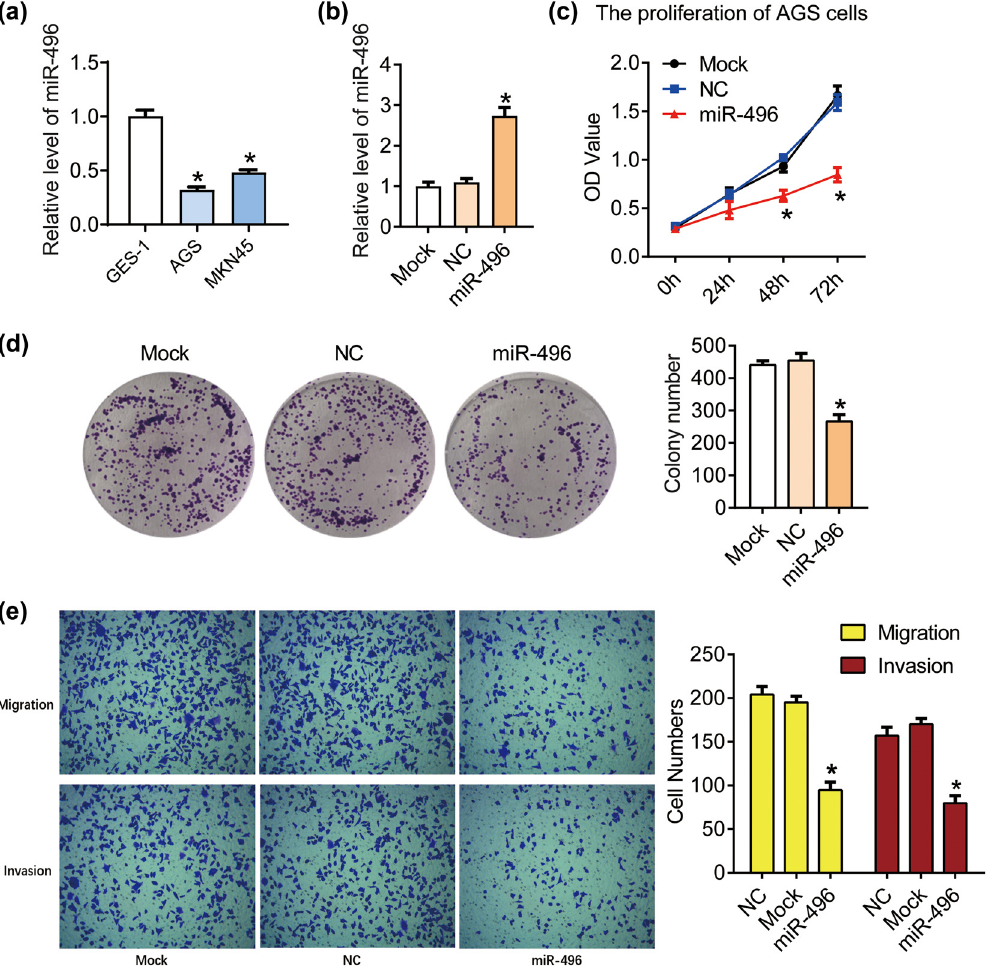
Figure 1: miR - 496 inhibited the proliferation and metastasis in gastric cancer cells. ( a ) QPCR was performed to detect the level of miR - 496 in AGS cells. ( b ) The level of miR - 496 in AGS cells transfected with miR - 496 mimics was detected by qPCR. Relative level of miR - 496 was analyzed using 2 − ΔΔ Ct method and normalized to mock group. ( c ) The proliferation of AGS cells was determined using CCK8 assay. OD value ( 450 nm ) was measured every 24 h. ( d ) Clonogenic assay was used to detect the proliferation of AGS cells. Colony number was counted 2 weeks after the culture. ( e ) The migration and invasion of AGS cells were detected by transwell assay after the transfection for 24 h. NC = negative control. * P <